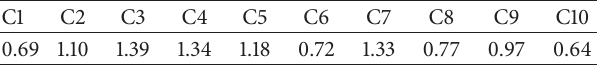
Table 1: Weight of ten Decision Stump classifiers.